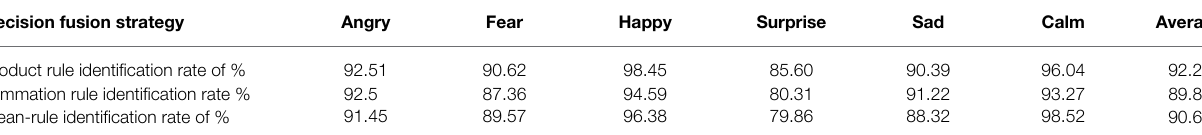
TABLE 3 | Experiment results of decision-making fusion emotion recognition. Decision fusion